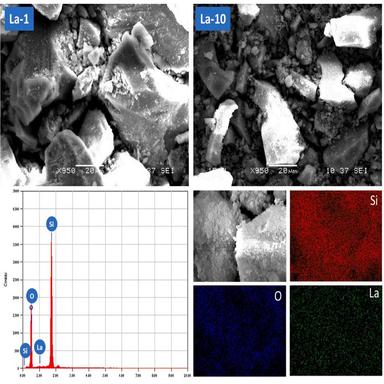
The SEM micrographs of La-1 and La-10 samples (top panels), The EDS and the mapping analysis of La-10 sample.